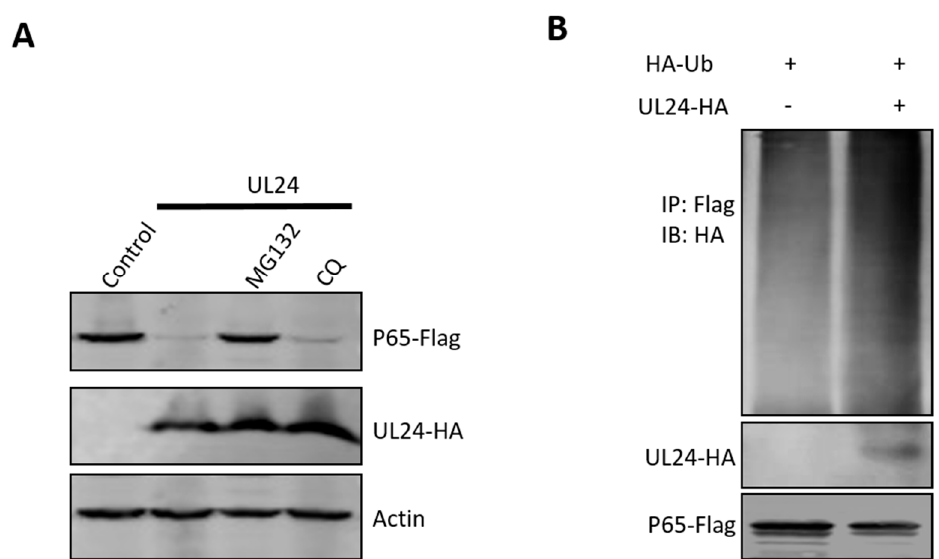
Figure 5. UL24 degrades p65 through the proteasome pathway. ( A ) HEK293T cells were co-transfected with a p65-Flag expression plasmid and a UL24 plasmid or an empty vector. Six hours later, the proteasome inhibitor MG132 (7.5 µM) and the lysosome inhibitor CQ (50 µM) were added. Cell lysates were analyzed by WB. ( B ) HEK293T cells were co-transfected with the HA-tagged UL24, FLAG-tagged p65, and HA-tagged Ub 30 h post transfection. The P65-ubiquitin complexes were immunoprecipitated using anti-FLAG antibody and immunoblotted with anti-HA antibody to detect ubiquitinated proteins.